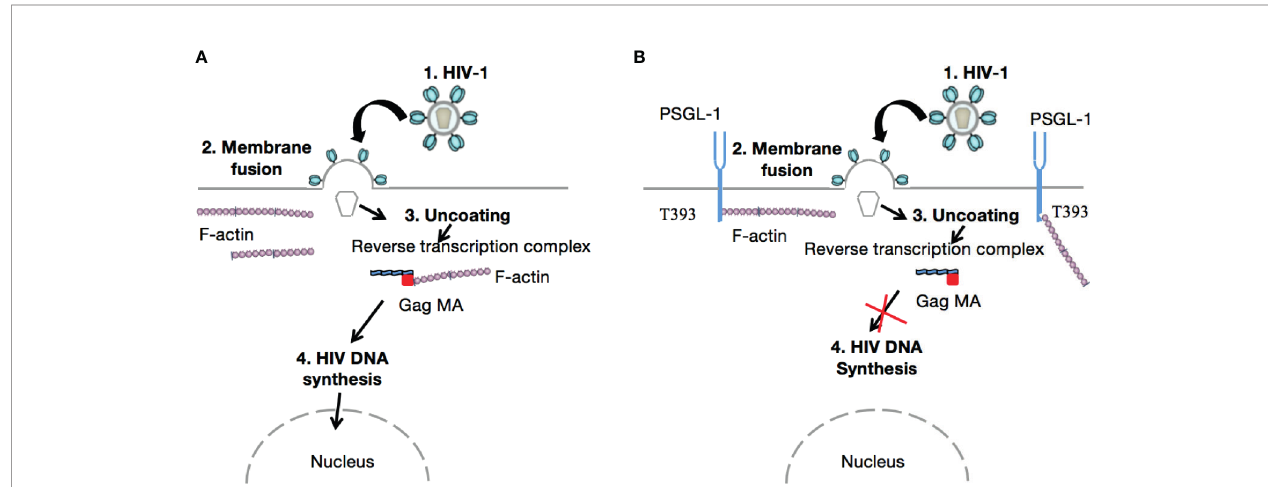
FIGURE 3 | Inhibition of HIV-1 reverse transcription. After attachment of the viral particle to the target cell and incorporation of the inner core into the cell cytoplasm, viral RNA is released (Uncoating). Thereafter, reverse transcription takes place in the cytoskeletal compartment. The viral reverse transcription complex interacts with F-actin via its gag MA domain to achieve cDNA synthesis (A) . However, in the presence of PSGL-1, which binds F-actin via its T393 conserved cytoplasmic domain, actin depolymerization or interaction with gag MA within the viral reverse transcription complex cannot occur (B) . Consequently, HIV-1 cannot recruit intact actin micro fi laments to complete reverse transcription; as reported by Bukrinskaya A et al., in 1998 (107).